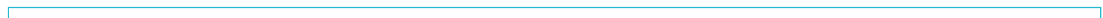
Figure 4: Generation of PDX models for preclinical studies. Patient-derived xenograft models of B-acute lymphocytic leukaemia (ALL), T- ALL and lymphoma can be generated from different disease time points like diagnosis, remission or relapse. PDX stability and complexity are highly conserved and can be proven by targeted sequencing, FISH (fluorescence in situ hybridisation) or FACS (fluorescence activated cell sort) analysis. PDX models can be used for a broad range of translation studies. Use of a co-culture system with mesenchymal stem cellss en- ables in vitro approaches for drug efficacy testing or biomarker identification. The high conservation of patient samples and xenografts enables the development of in vivo models for pharmacological screens, cell manipulations with CRISPR or the study of niche interactions in the mi- croenvironment of the cancer